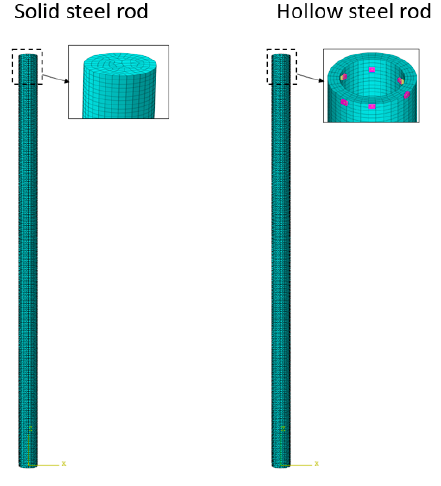
Figure 9. Numerical model built using ABAQUS.